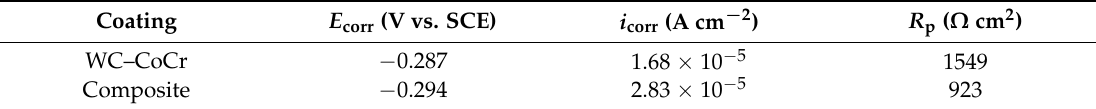
Figure 10. Potentiodynamic polarization curves of the as-sprayed coatings in 1 M HCl solution. Table 3. Electrochemical parameters derived from the polarization curves of the as-sprayed coatings in 1 M HCl